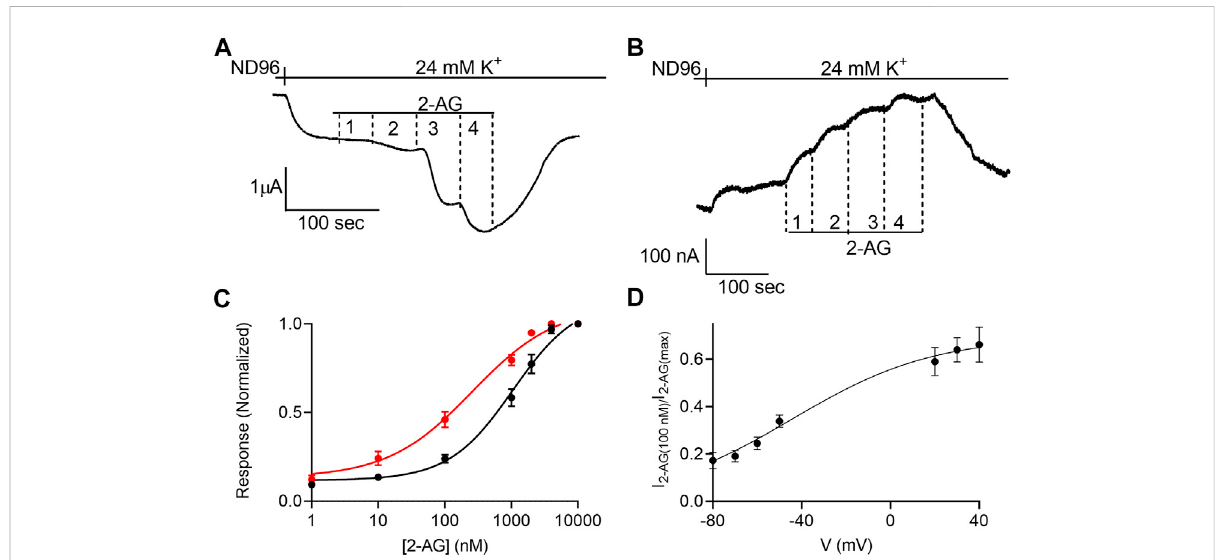
FIGURE 1 Voltage dependence of the potency of 2-AG. (A) and (B) . Measurement of the relationship between 2-AG concentration and GIRK currents at -80 mV and at +40 mV, respectively. Basal GIRK current is evolved following replacement of the solution to a high K+ solution. Then, 4 different 2- AG concentrations (100, 1,000, 2000 and 10000 nM) were applied and the response for each concentration was measured. (C) . Dose response curves for several 2-AG concentrations at − 80 mV (black symbols and line; n = 19, 45, 51,39, 9, 19 and 39for 1, 10,100, 1,000, 2000, 4,000 nM respectively) and at +40 mV (red symbols and line; n = 8, 26, 28, 15, 19, 12 and 39 for 1, 10, 100, 1,000, 2000, 4,000 nM respectively). The responses arenormalizedtotheresponseevokedby10000 nM2-AGateachholdingpotential. (D)